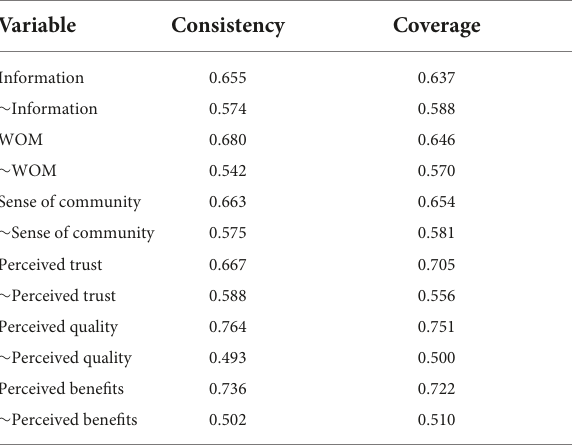
TABLE 3 Analysis of necessary conditions.